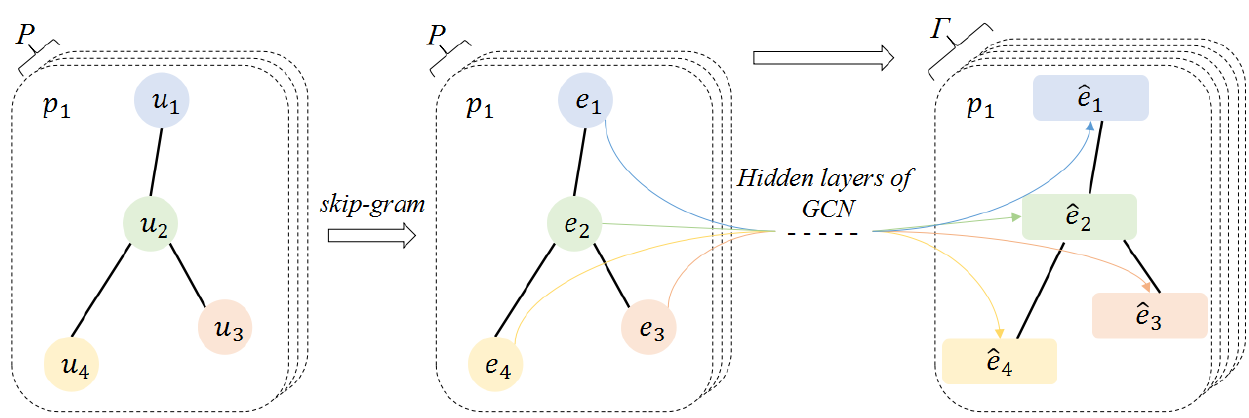
Figure 3. Schematic of GCN simulated